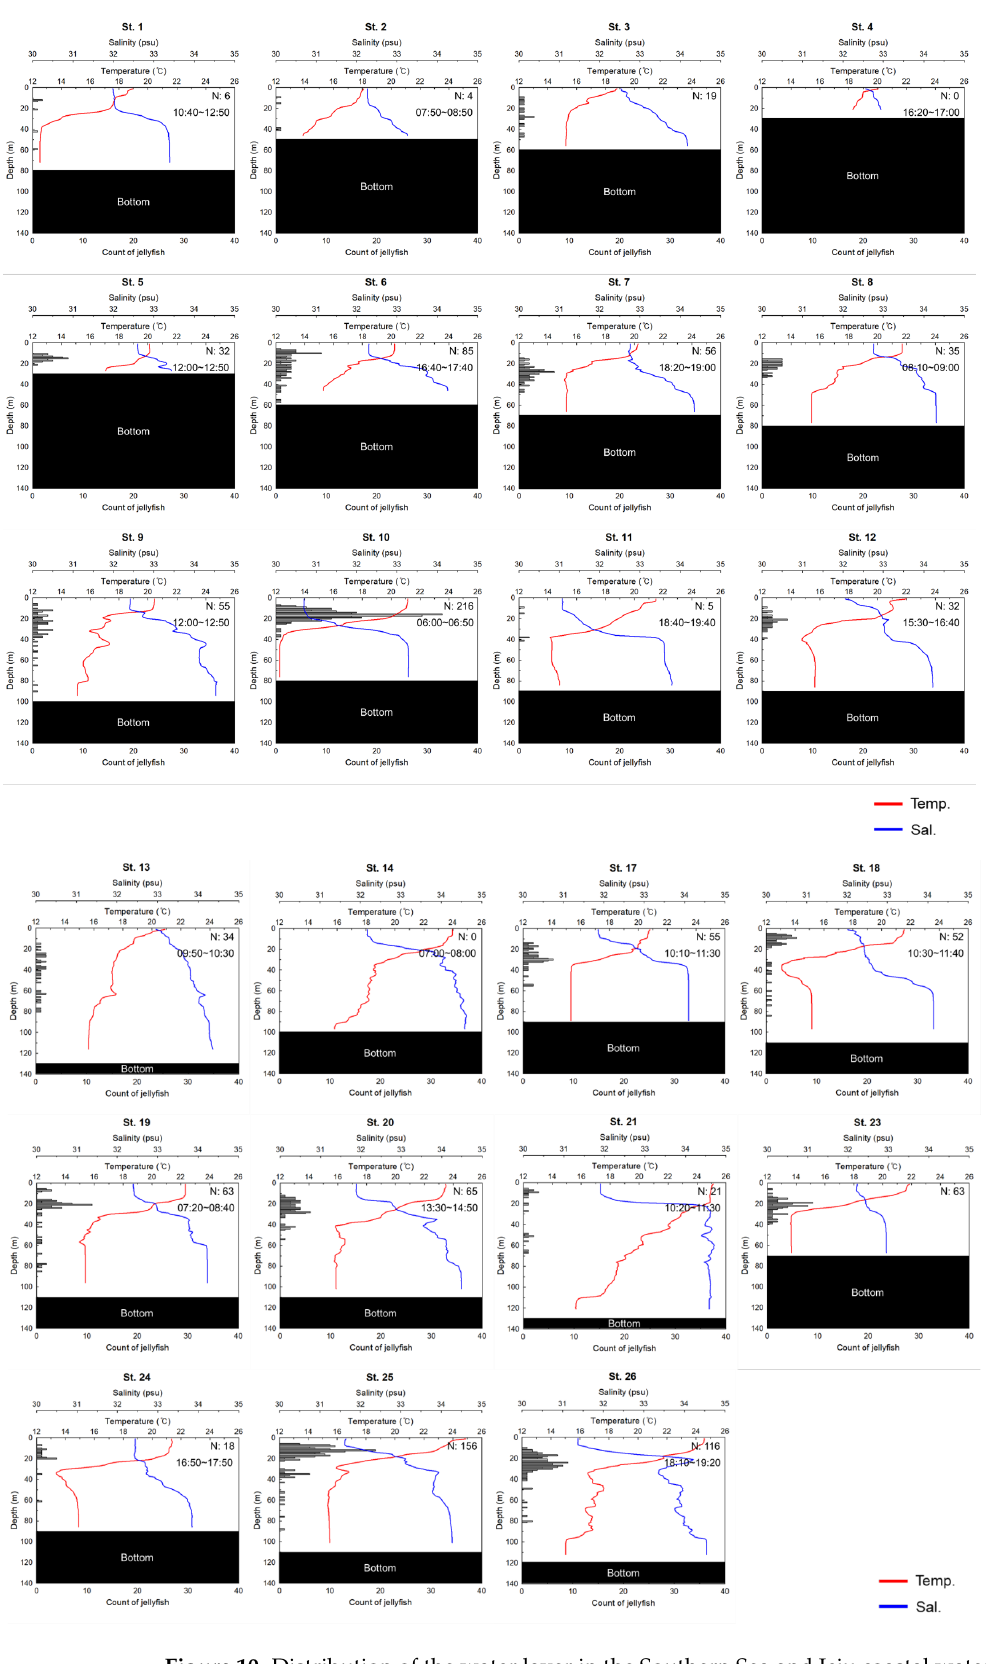
Figure 10. Distribution of the water layer in the Southern Sea and Jeju coastal waters. Table 6. Distribution density of jellyfish using the echo counting method in the Southern Sea and Jeju coastal waters.